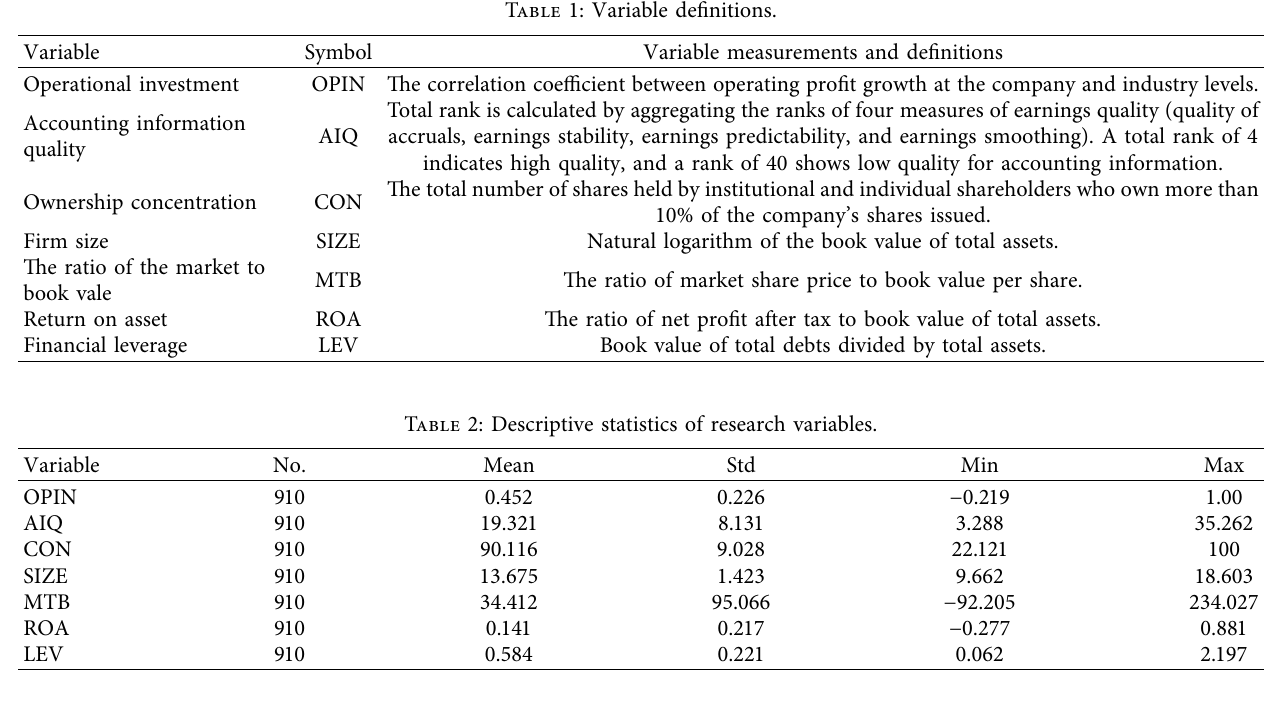
Table 3: The results of Chow and Hausman tests.